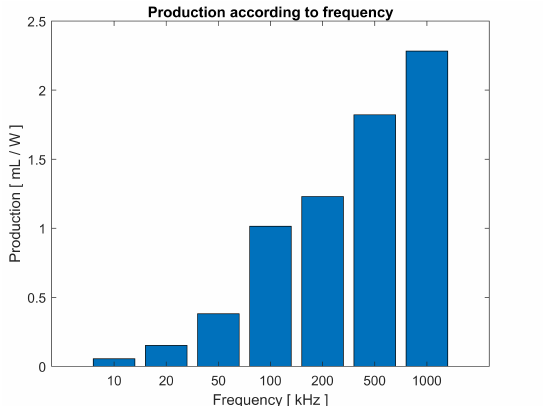
Figure 10. Gas production according to applied pulse frequency, with 4 V at the source and 0.1 mm separation between electrodes.